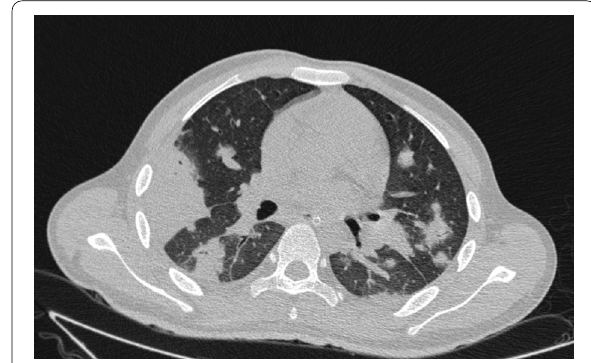
Fig. 1 High-resolution computed tomography chest (lung window) on day 11 of admission shows multiple patchy to confluent areas of air space opacifications in bilateral lung parenchyma